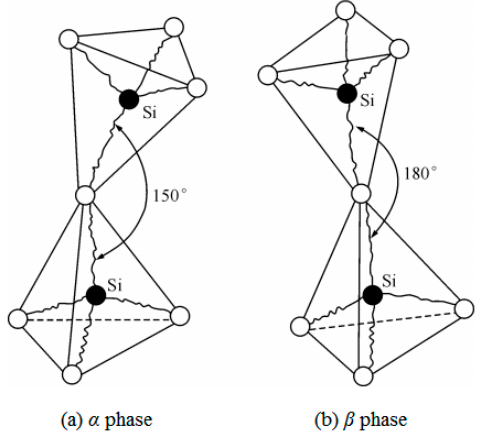
Figure 17. Diagram of change in the quartz bond angle from α phase ( a ) to β phase ( b ) [89].